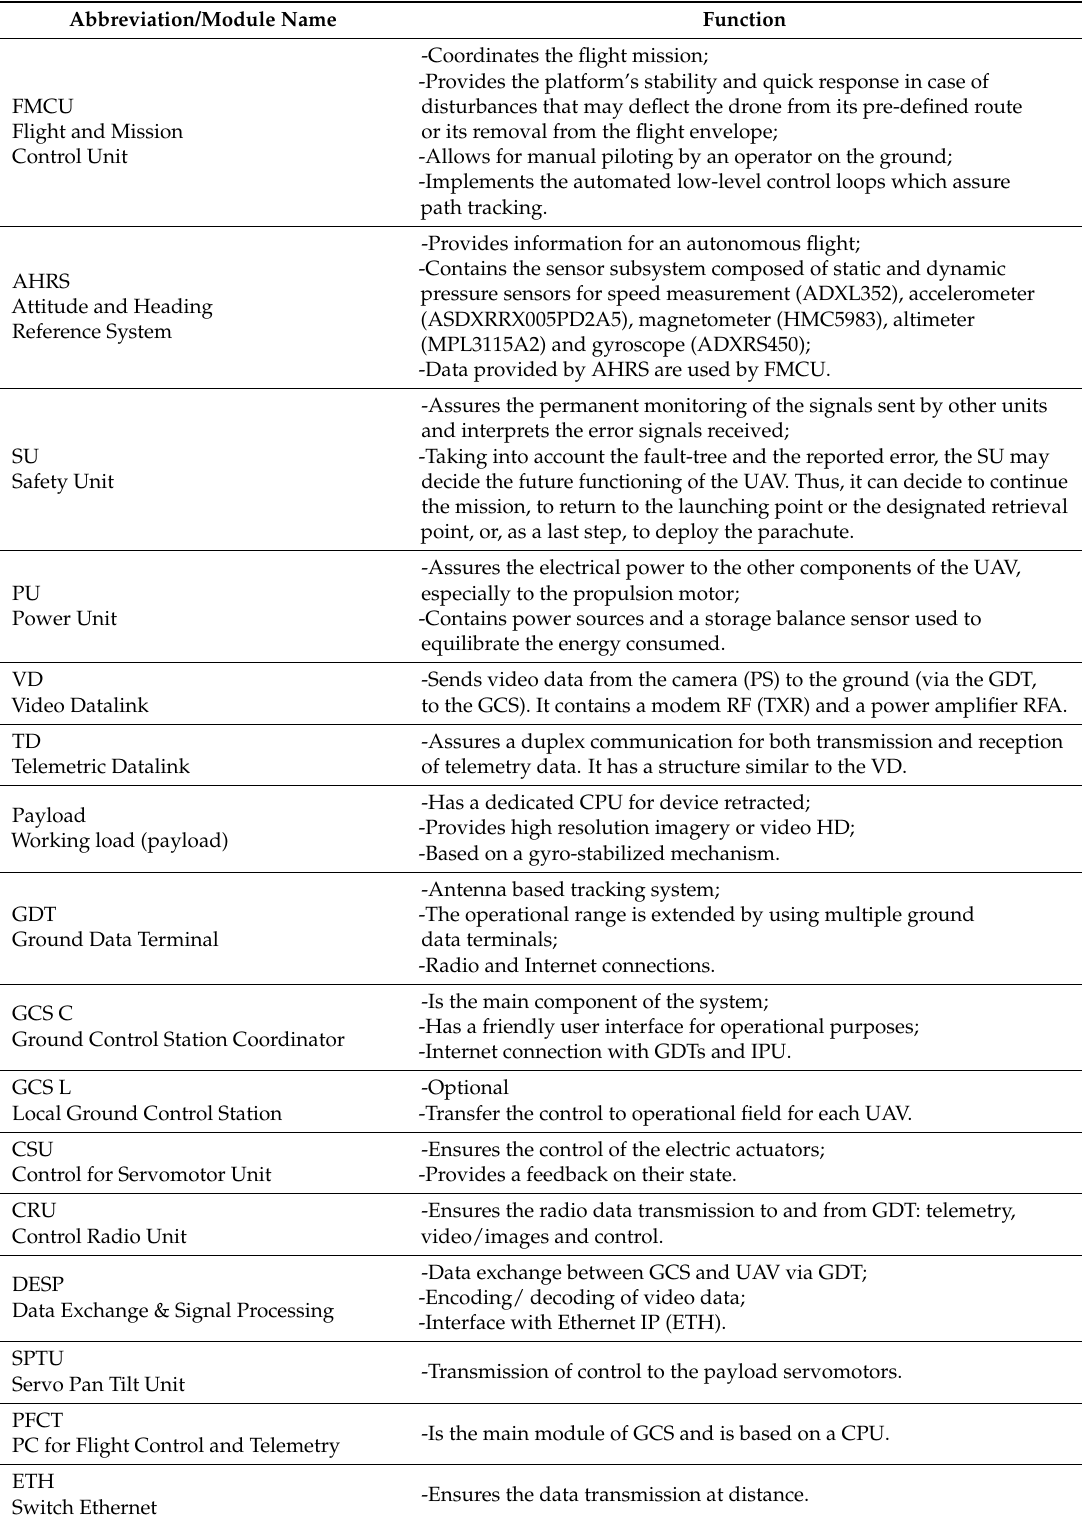
Table 1. MUROS UAV—Abbreviations and